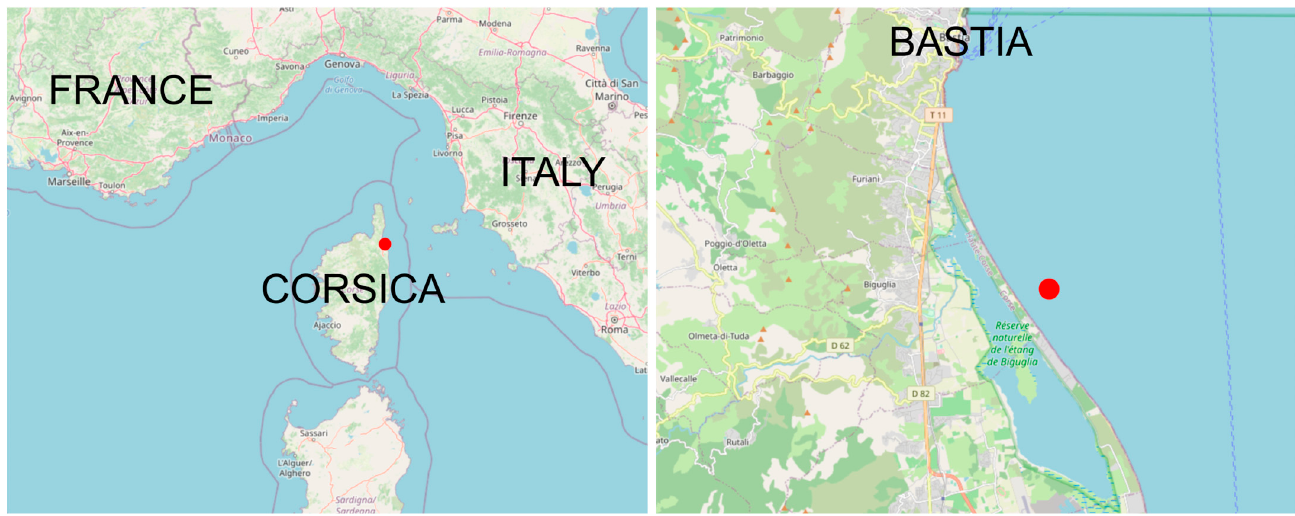
Figure 7. The experiment took place near the coastline south of the city of Bastia, in Corsica, a French Mediterranean island located between France and Italy. Red dot represents the location of the